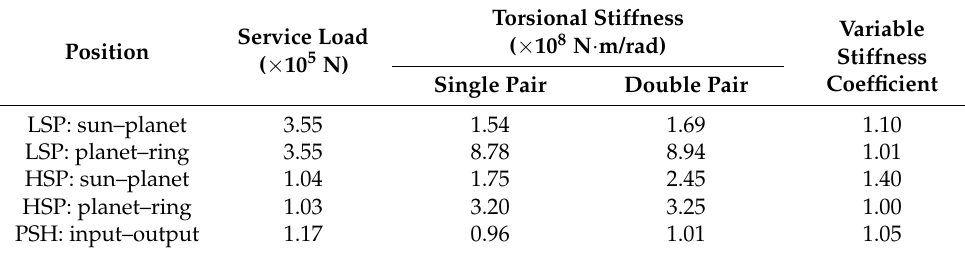
Figure 7. Parameter identification of gear meshings, connections and shafts by means of FEA. Table 4. Parameter identification results of the gear meshings.